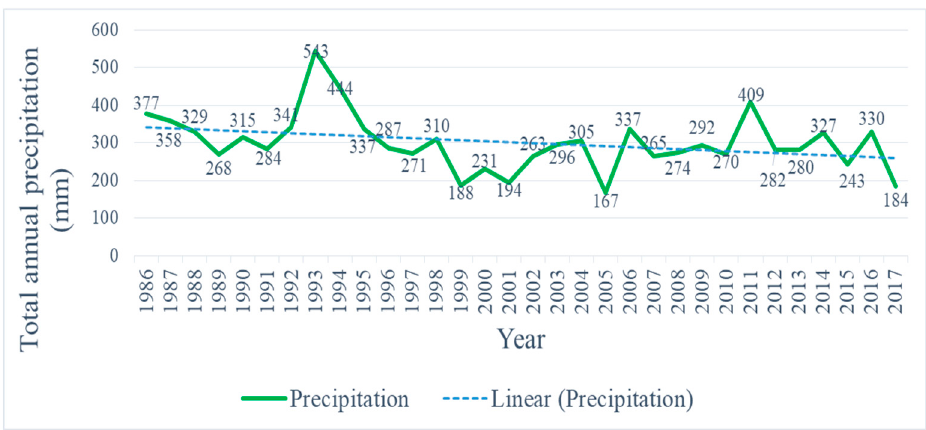
Figure 6. Precipitation values of Urmia Lake from 1986 to 2017.